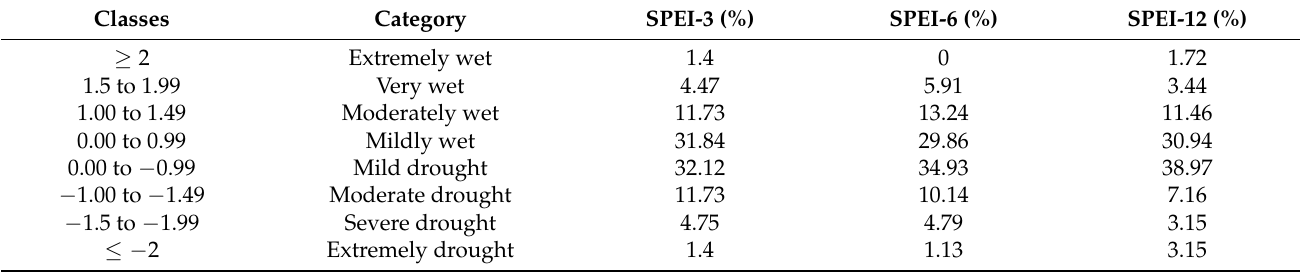
Table 1. Classification of SPEI over Myanmar during